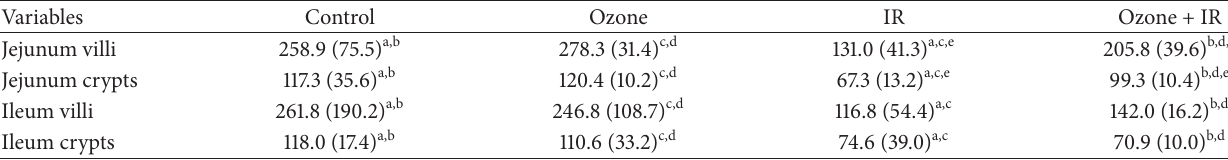
Table 1: Evaluation of villus height and crypt depth in study groups.